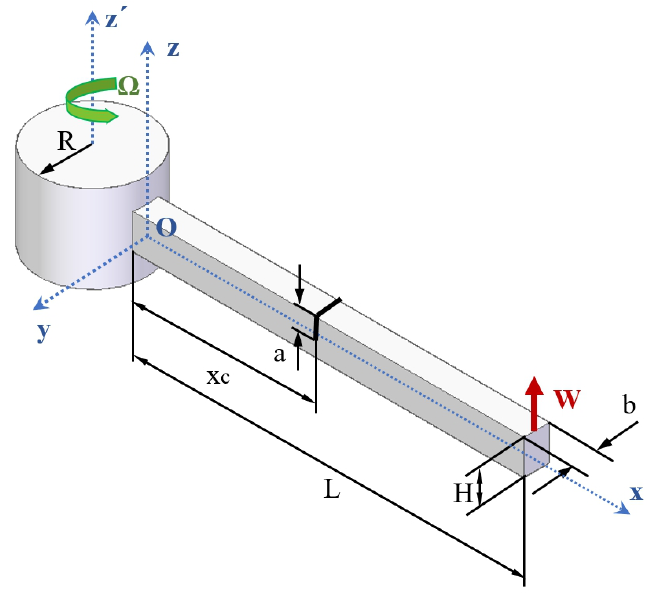
Figure 1. Scheme of the cracked rotating